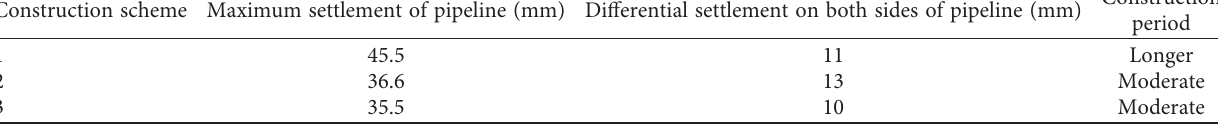
Table 4: Comparison of simulation results of construction schemes.